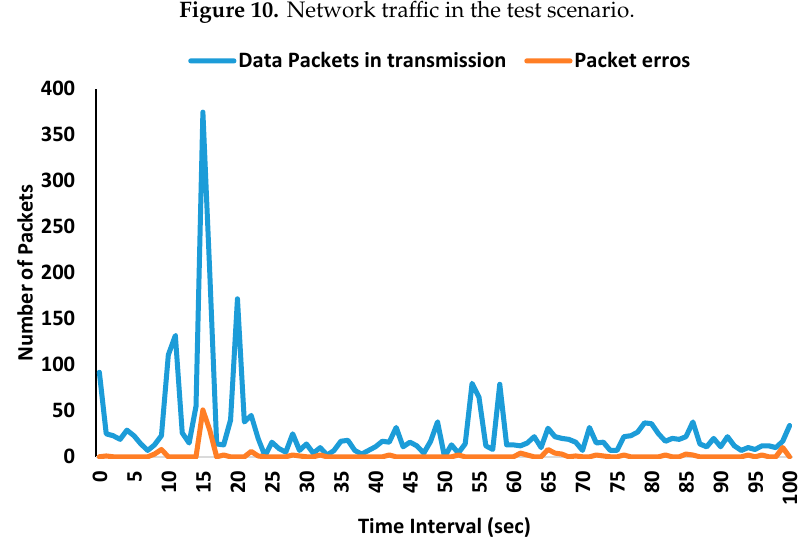
Figure 11. Network analysis, server traffic.